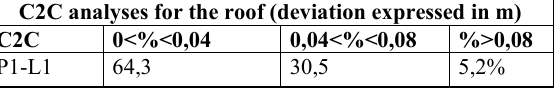
Table 4. C2C analyses roof dataset. For each dataset values are reported as percentages in a selection of ranges.